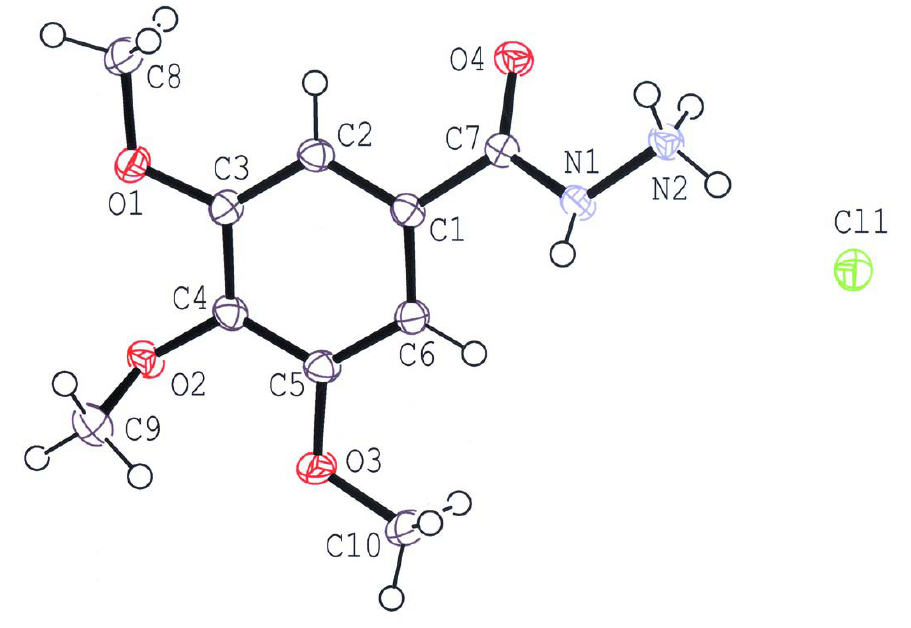
Figure 1 The molecular structure of the title molecule, with the atom-numbering scheme. Displacement ellipsoids are drawn at the 50% probability level.